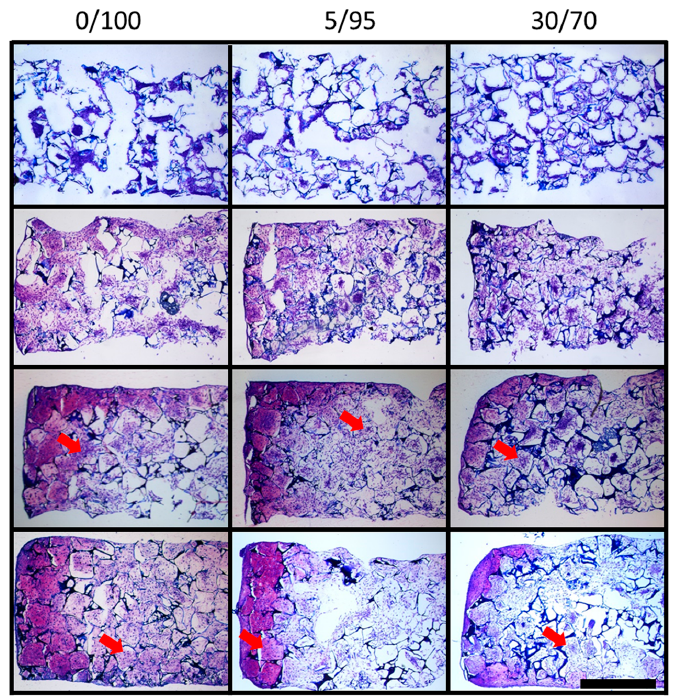
Figure 5. Dimethylmethylene blue (DMMB) staining for glycosaminoglycan content of MSC seeded scaffolds of different ratios of hyaluronic acid and gelatin throughout chondrogenic differentiation: first row day 1, second row day 7, third row day 14 and fourth row day 21 (scale bar = 1 mm). Arrows indicate ECM in the lumen of the scaffold pores, located pericellular to intraluminal MSCs.